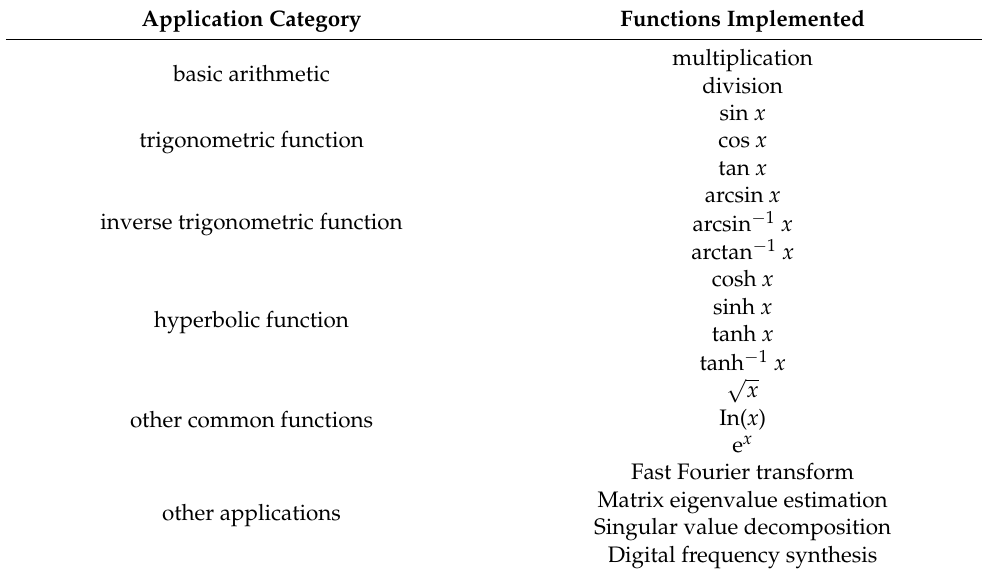
Figure 2. Edge computing framework based on heterogeneous computing. Table 1. Application of CORDIC Algorithm.